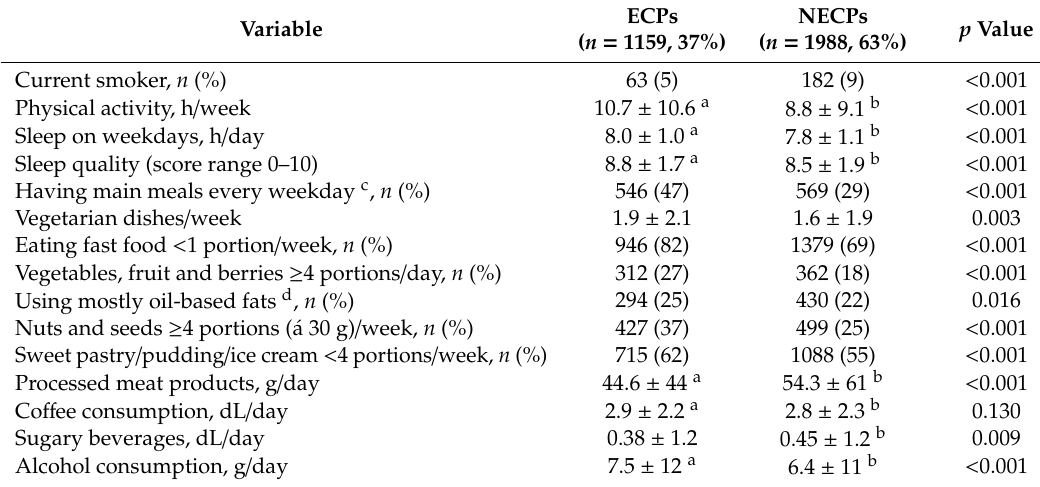
Figure 1. The means ( ± SD, standard deviation) of total eating competence scores and its subscores in eating competent ( n = 1159) and not eating competent participants ( n = 1988). Possible score ranges are 0–48 for total eating competence, 0–18 for eating attitudes, 0–15 for contextual skills, 0–9 for food acceptance and 0–6 for internal regulation. *** p value < 0.001. Table 2. Lifestyle patterns in eating competent participants (ECPs) ( ≥ 32 points) and not eating competent participants (NECPs) ( < 32 points).